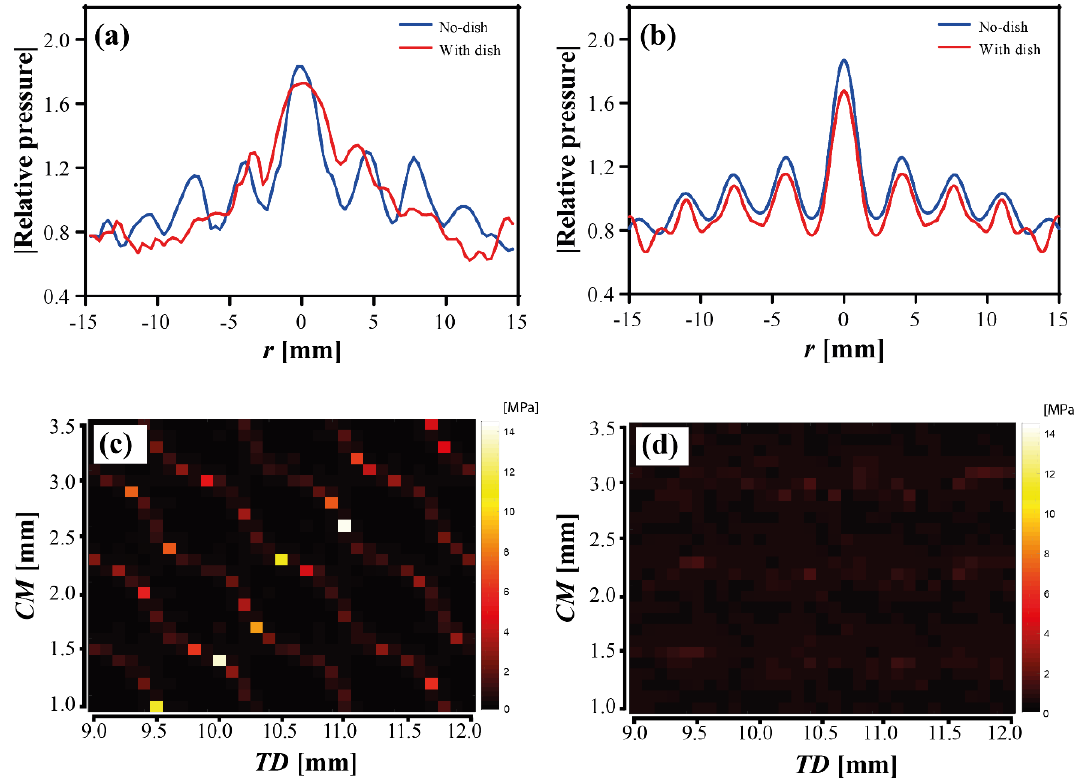
Figure 3. ( a ) Measured ultrasound pattern through the culture dish compared with the no-dish condition. ( b ) Model of transmitted ultrasound pattern through the dish and no-dish condition using a time-dependent simulation of 10 sine-cycles. ( c ) Resonances for different distances between the transducer and the culture dish ( TD ) versus the depth of culture medium ( CM ) with the dish and transducer surfaces perfectly parallel. ( d ) Resonances for the same distances of ( c ) with ξ = 2 ◦ and ϕ = − 1 ◦ . For ( a ) and ( b ), the acoustic pressure is relative to the average pressure in free-space at the transducer surface in the effective radiating radius [22].